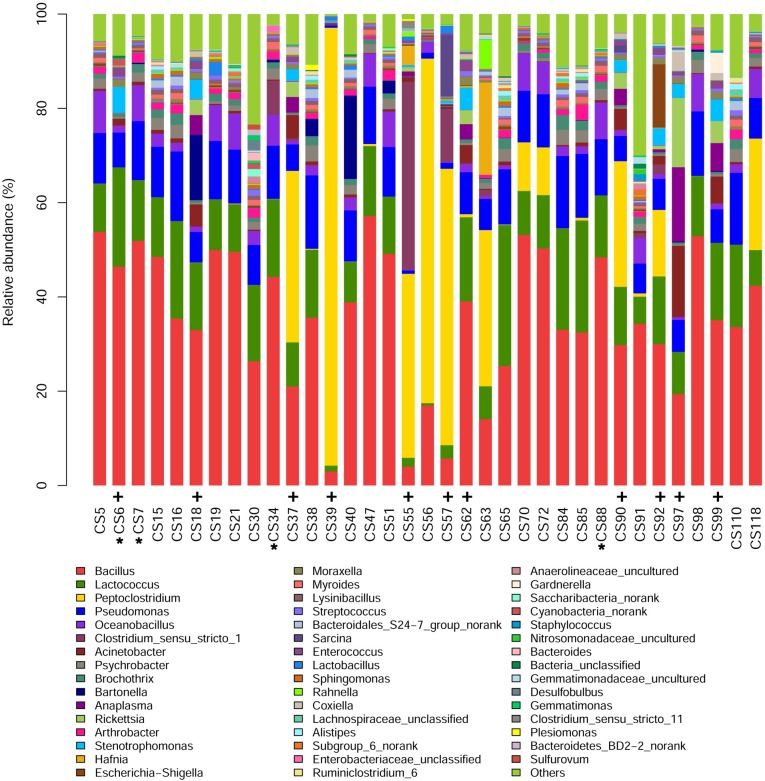
Spleen microbiota compositions at genus level.Color-coded bar plot showing the proportion of different bacterial genera present in 35 mouse and shrew samples from Chongming Island, Shanghai city. The 4 shrew samples were marked with *, and the left 31 samples were mice; Samples marked with + were Anaplasma-positive. Taxa with <1% abundance were listed as others.